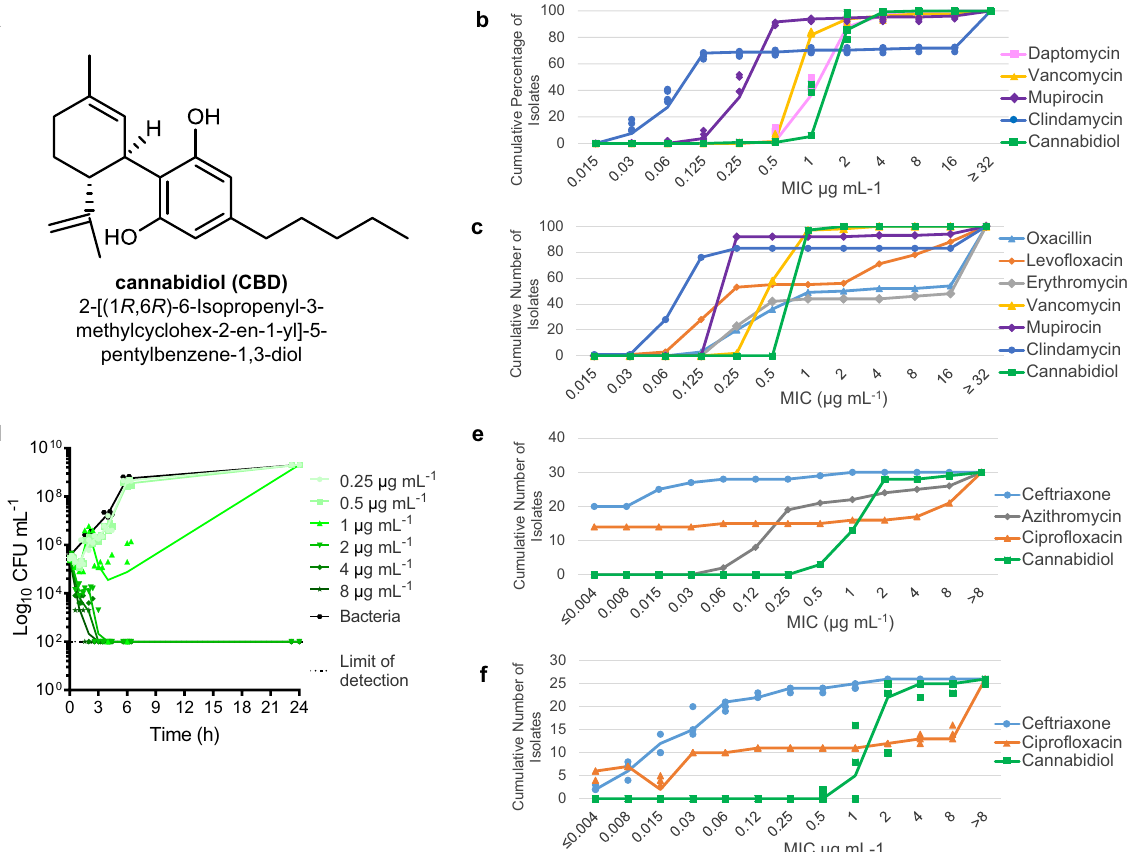
Fig. 1 Antibacterial activity of cannabidiol. a Structure of CBD. b MIC 90 distribution of CBD against 132 Australian S. aureus isolates. Cumulative percentage of isolates below or equal to a given MIC are indicated. Data are n = 4 biologically independent samples for MIC of each isolate. c MIC 90 distribution of CBD against 100 USA S. aureus isolates. Cumulative number of isolates below or equal to a given MIC are indicated. Data are n = 1 for MIC of each isolate. d Time-kill assay of CBD against MRSA ATCC 43300. Data are mean ± SD for n = 4 biologically independent samples. e Broth microdilution MIC distribution of CBD against 30 N. gonorrhoeae isolates. Cumulative number of isolates below or equal to a given MIC are indicated. Data are n = 1. f Agar microdilution MIC distribution of CBD against 26 N. gonorrhoeae isolates. Cumulative number of isolates below or equal to a given MIC are indicated. Data are n = 3 independent